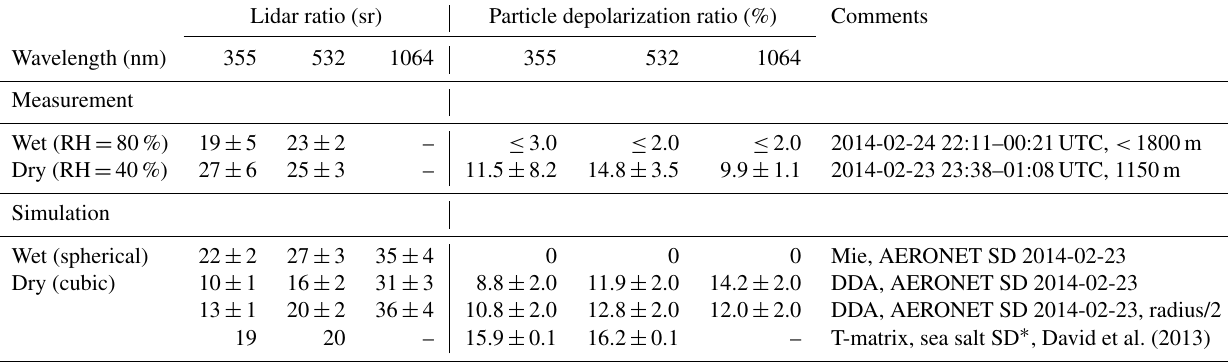
Table 1. Measurement and simulation of the lidar ratio and the particle linear depolarization ratio for wet and dry marine particles. The depolarization ratio (100m vertical smoothing) and the lidar ratio (500m vertical smoothing) are measured at the indicated height, to which the given RH value belongs. The systematic uncertainties are given. The lidar ratio at 1064nm could not be measured in this configuration of BERTHA (see Haarig et al., 2016b). For the DDA simulation of spherical and cubic particles the AERONET size distribution (SD) from Ragged Point at 12:31UTC on 23 February 2014 is taken. The effective radius was 1.033µm. In order to mimic dry marine particles, the radius of the size distribution was divided by a factor of 2. For the wet marine particles a mixture of 7 : 1 parts of water to salt was used. The model uncertainties are described in Sect. 3.3. The T-matrix results for a typical size distribution of sea salt (O’Dowd et al., 1997) are taken from David et al. (2013). The modeled uncertainties are extremely small, less than 1sr for the lidar ratio. Lidar ratio (sr) Particle depolarization ratio